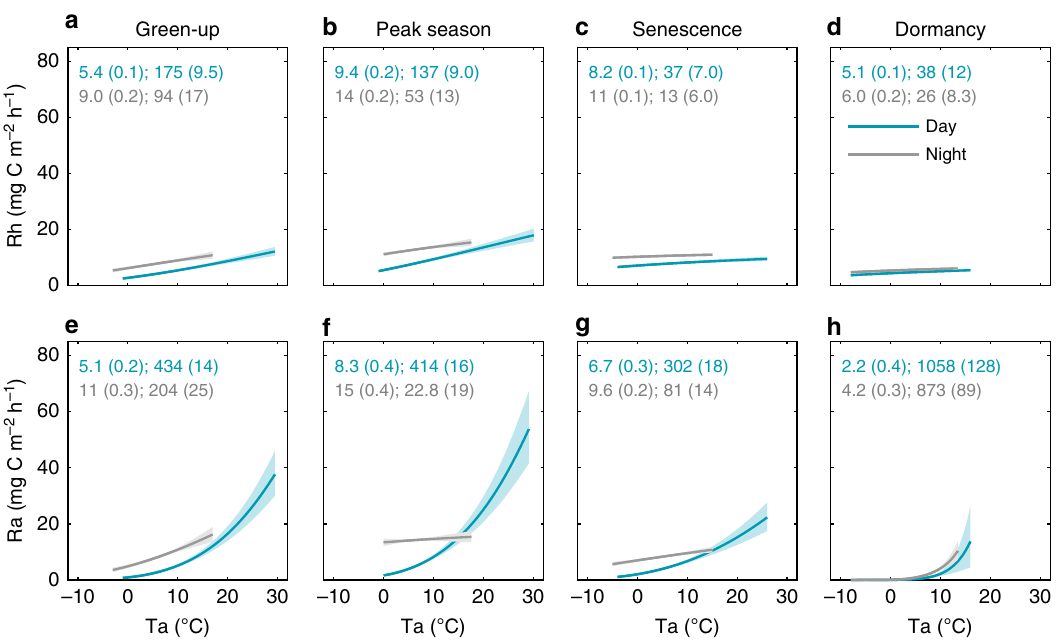
Fig. 6 Diel temperature responses of heterotrophic and autotrophic respiration. Exponential regression relationships between a – d heterotrophic respiration (Rh) and e – h autotrophic respiration (Ra) and air temperature (Ta) for day- and nighttime (i.e., photosynthetic photon fl ux density ≥ 20 and <20 μ mols m − 2 s − 1 , respectively) during the key phenophases of green-up, peak season, senescence, and dormancy (spring and autumn) shown as a mean of the years 2015 – 2016. Values shown in the panels (blue and gray for day- and nighttime periods, respectively) represent model parameters R 10 and E 0 with standard errors in brackets from the Lloyd & Taylor 14 respiration model (see equation in Methods). Solid lines indicate the exponential fi t and shaded bands indicate the 95% con fi dence